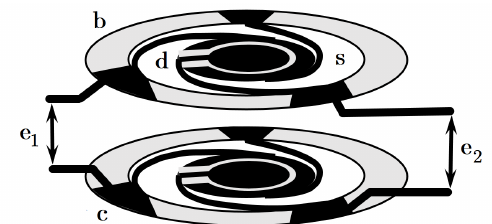
Figure 1. Schematic description of the electrostatic transducer subjected to control action. It consists of a moveable disk (d) with coaxial sensing and actuating electrodes, attached to the base (b) through spiral springs (s). Electrical connections are realized on contacts (c). The position sensing signal is fed to terminals (e 1 ) and the electrostatic actuation is applied to terminals (e 2 ). The geometrical separation of sensing and actuating electrodes minimizes the effect of direct capacitive